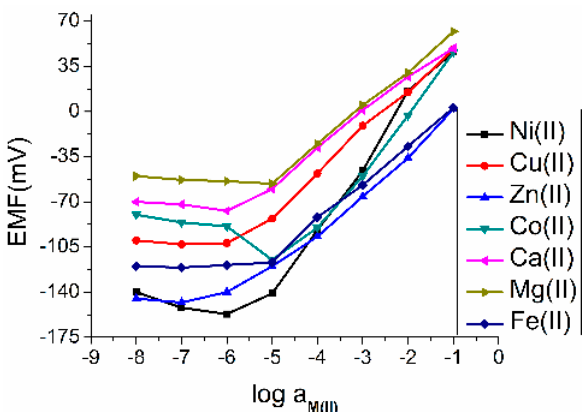
Figure 2. Trends of electromotive force (EMF) responses as a function of concentration by N , N -bis(2- nitrophenyl)benzene-1,2-diamine (TPA) towards different metal ions.